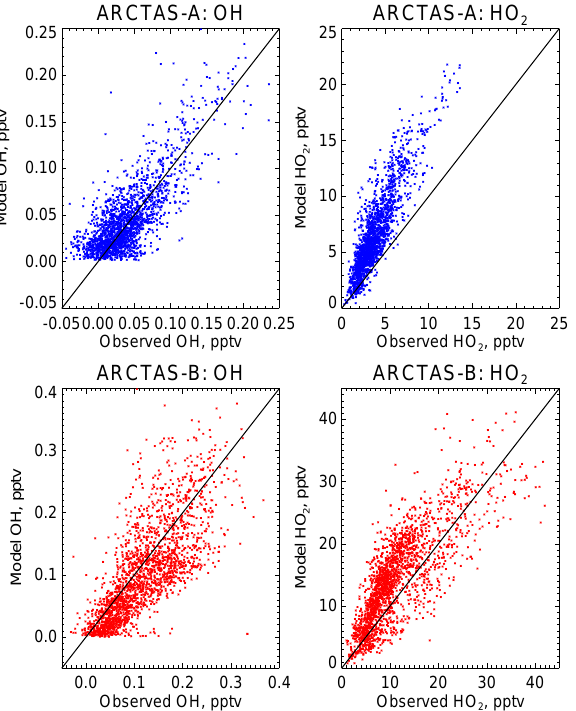
Fig. 9. Scatter plot of observed versus model-predicted (a) OH and (b) HO 2 during ARCTAS-A, and (c) OH and (d) HO 2 during ARCTAS-B. The one-to-one line is shown in black.